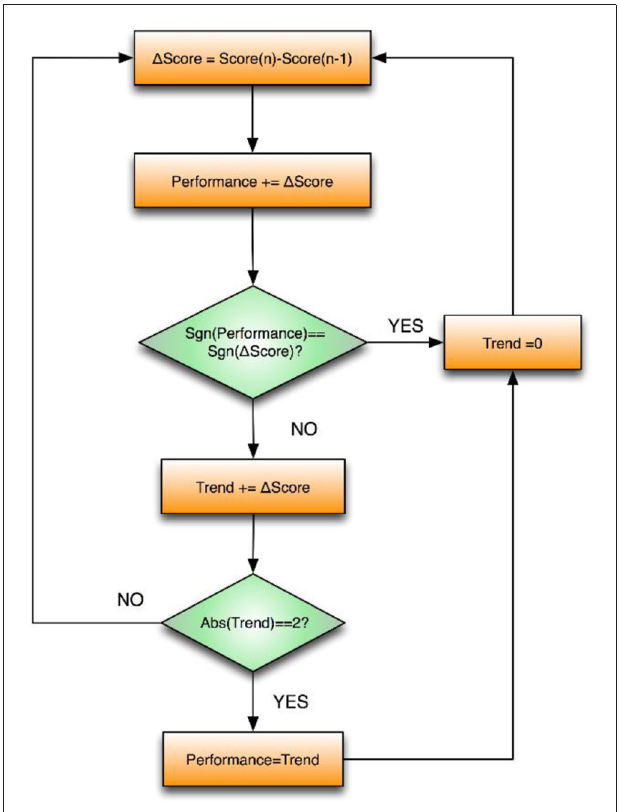
FIGURE 3 | Schematic overview of the logic for calculating the performance trend in the VR game.